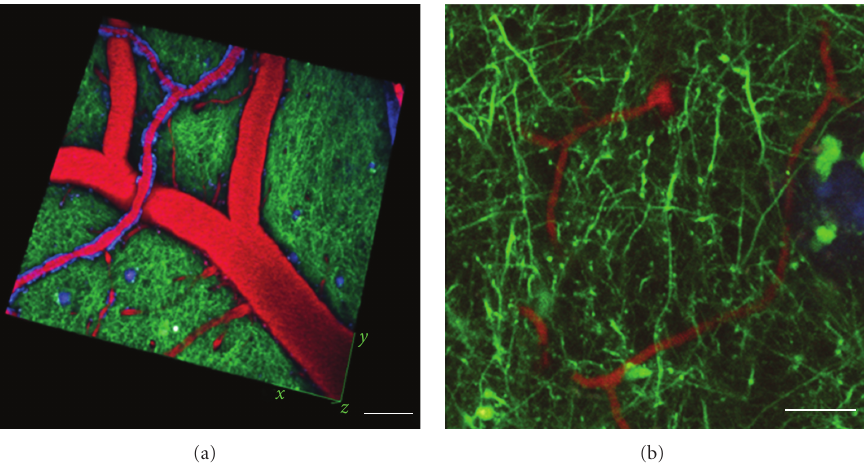
Figure 1: In vivo multiphoton imaging of plaques (labeled with methoxy X-O4, blue), vasculature (labeled with Texas red dextran, red), and dendrites (transgenically expressing YFP, green) in mice transgenic for mutant human APP and PS1 crossed with YFP transgenic mice allow examination of dendritic spine plasticity and loss. Low-resolution three-dimensional image stacks (a) are used to repeatedly find the same imaging sites. Higher-resolution image stacks (b) are used for spine analysis. Scale bars 100 μ m (a) 10 μ m